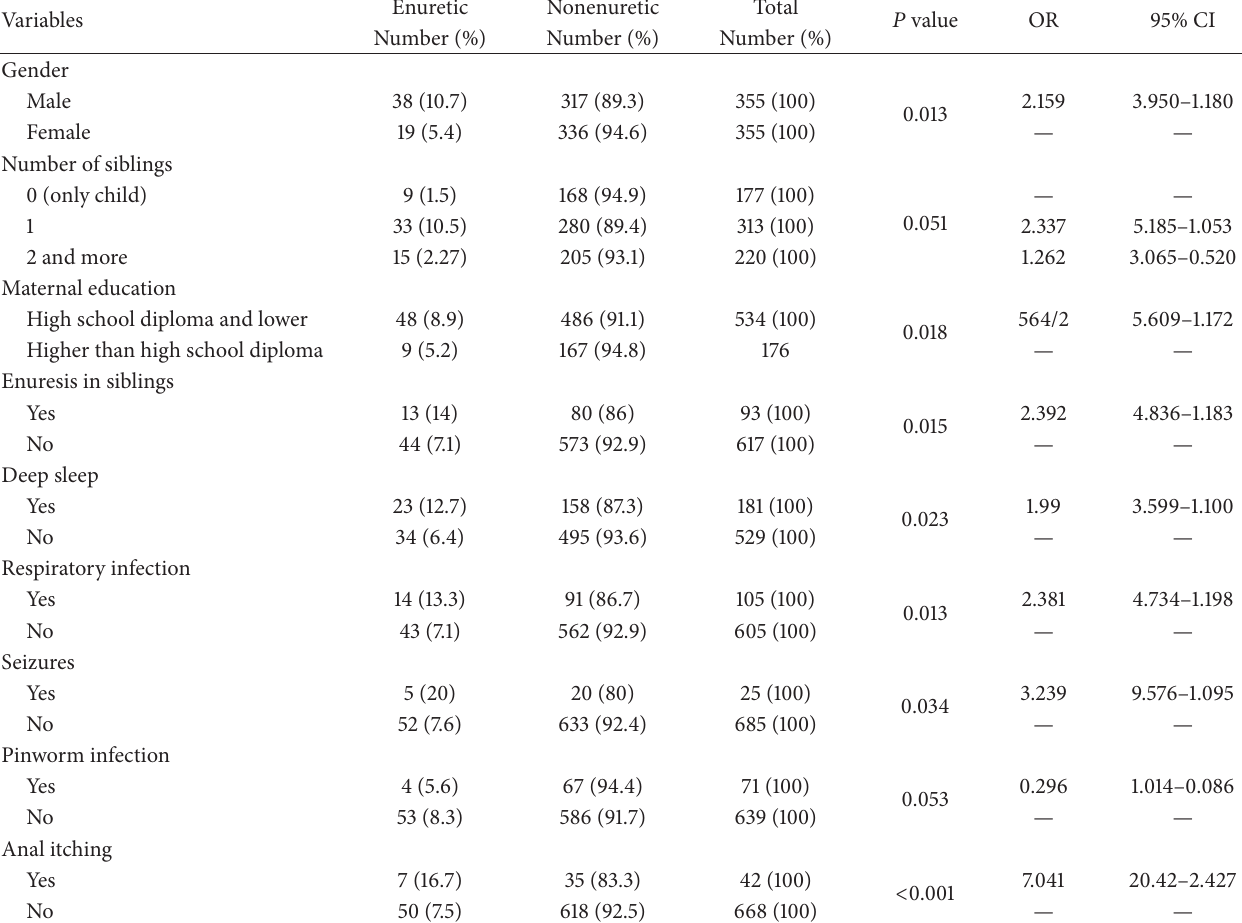
Table 4: Factors associated with nocturnal enuresis based on the logistic